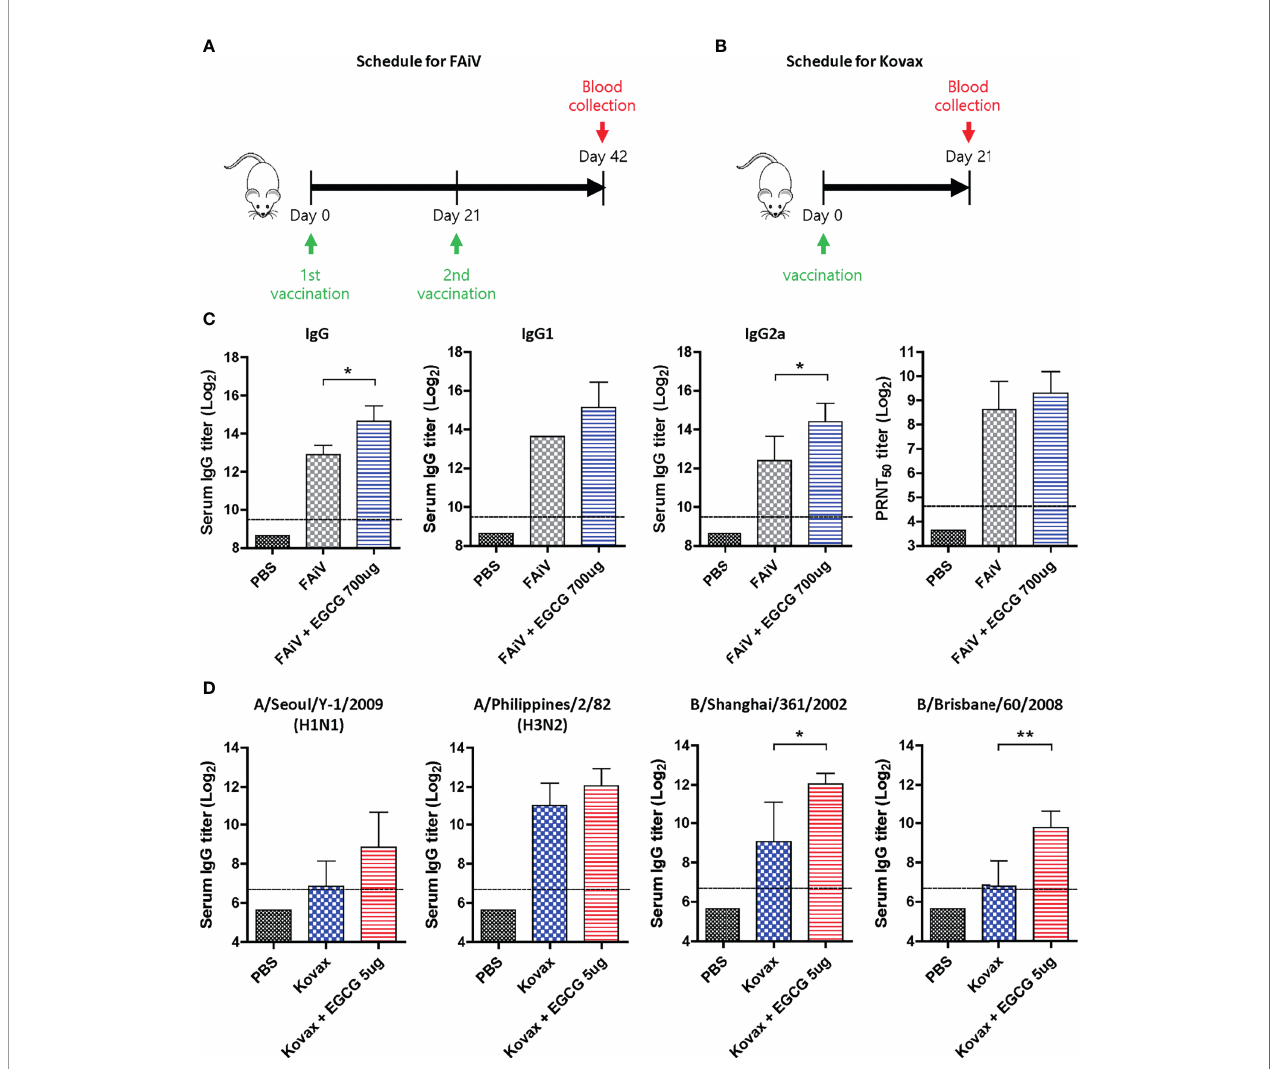
FIGURE 7 | Adjuvant effect of EGCG to other types of vaccine. (A) Vaccination and blood collection schedule for FAiV. PBS or 2 × 10 6 PFU of FAiV with or without EGCG were injected into mice via IP route twice every 3 weeks. Sera were collected 3 weeks after the last vaccination. (B) Vaccination and blood collection schedule for Kovax is shown. PBS or 6 m g of Kovax (1.5 m g of each antigen derived from four different strains) with or without EGCG were injected into mice via IM route once. Sera were collected 3 weeks after the vaccination. (C) Total IgG, IgG1, and IgG2a antibody responses or neutralizing antibody responses to in fl uenza PR8 virus. The detection limit of ELISA antibody and PRNT 50 titers (dashed lines) were 800 and 25, respectively. (D) Serum IgG titers speci fi c for four different in fl uenza strains are shown. The detection limits (dashed lines) were 100. Data of antibody titers (C, D) were log-transformed and expressed as means (bar graphs) and standard deviations (error bars). Student ’ s t -test was used to compare two different groups (** P < 0.01; * P <